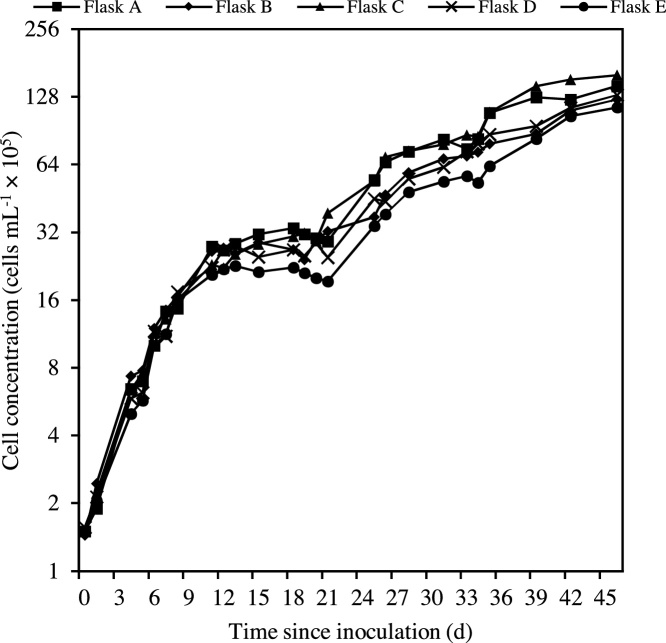
Logarithmic growth curves for the five experimental cultures of Microcystis aeruginosa CPCC 300 since time of inoculation.